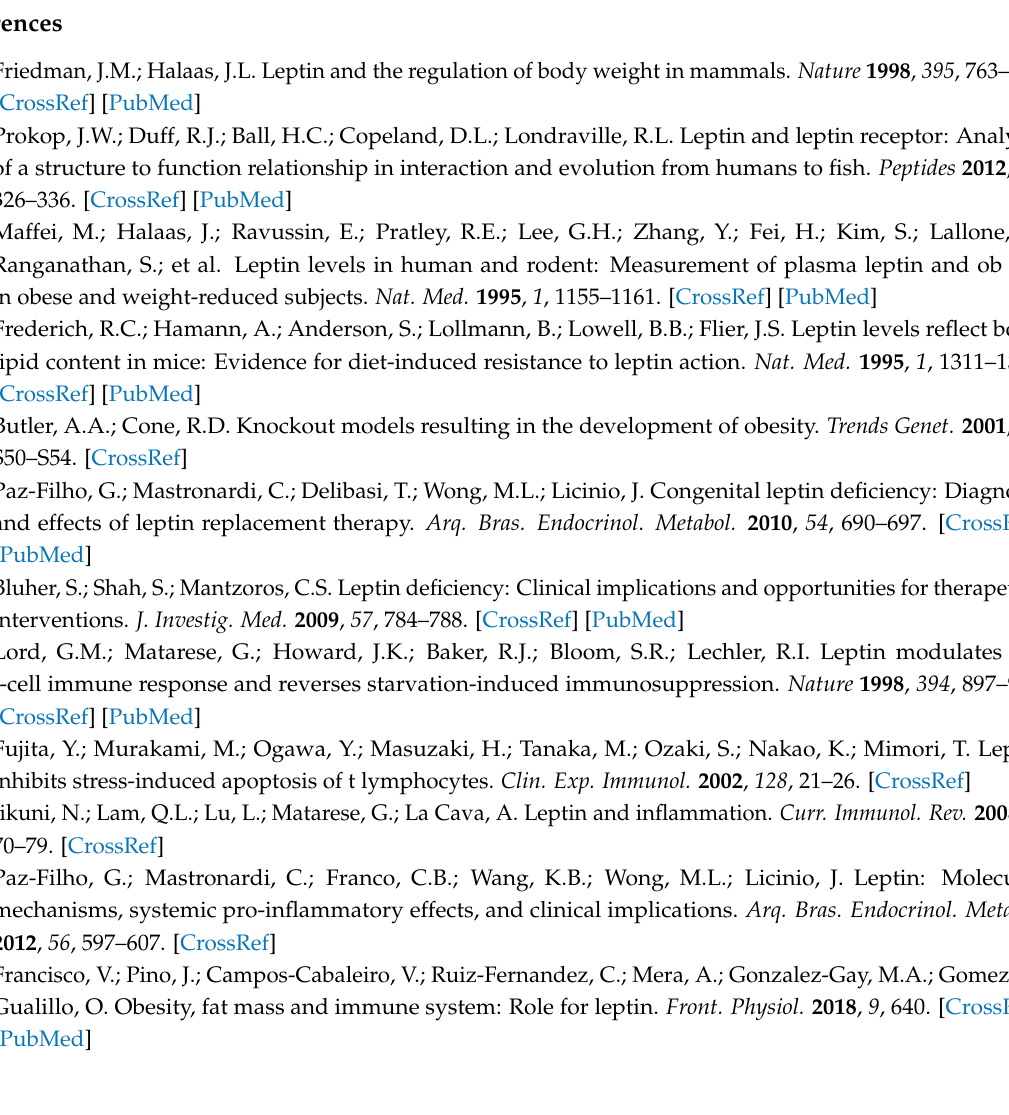
Figure A1. Passive avoidance test on training and memory of control (black) and lepa KO (red) zebrafish. Data were presented as means ± standard error of the mean (SEM) ( n = 12) and were analyzed individually for each treated group. Statistical analysis was performed by one-way ANOVA, followed by Tukey post hoc test.